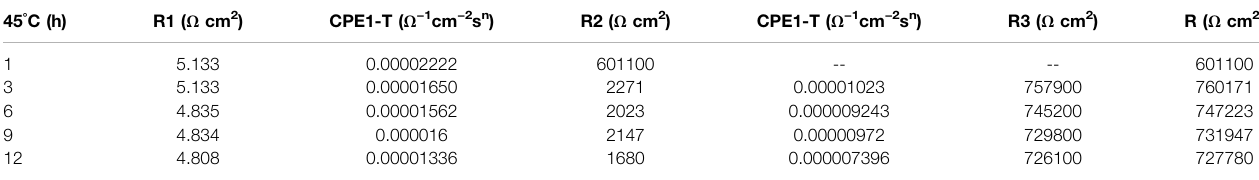
TABLE 8 | Impedance fi tting data of the heat affected zone soaked in arti fi cial seawater at 45 ° C for 12 h 45 ° C